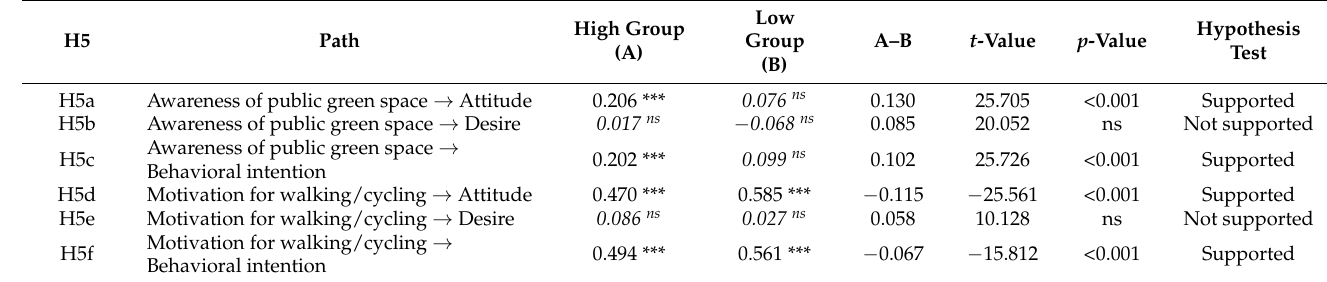
Table 3. Moderating role of high and low perceived usefulness of smart